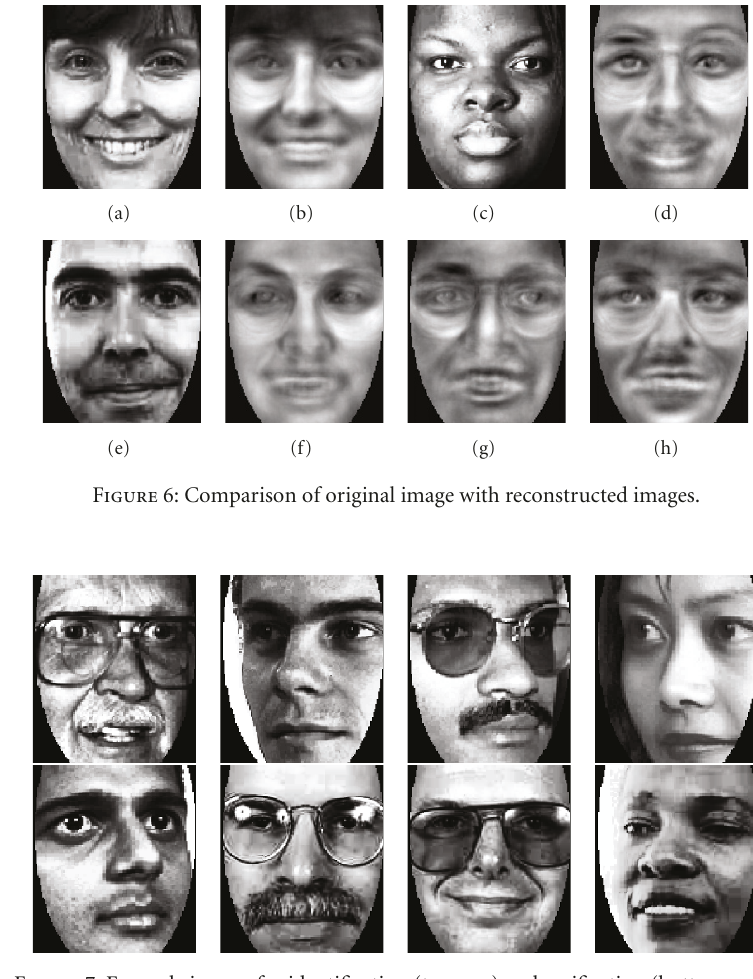
Figure 7: Example images for identification (top row) and verification (bottom